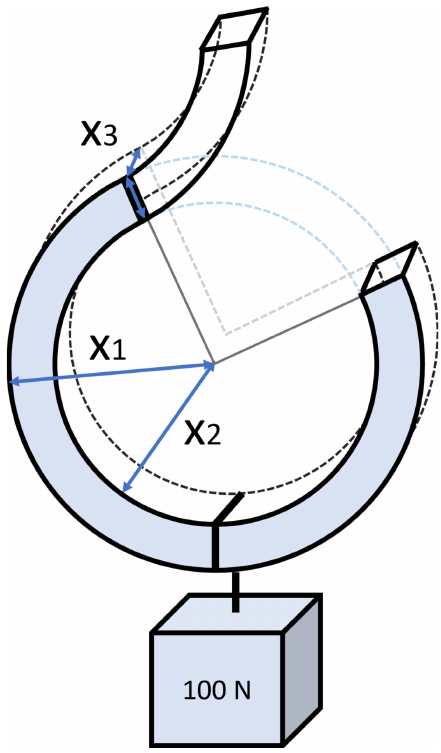
Figure 3. Schematic view of the crane hook design